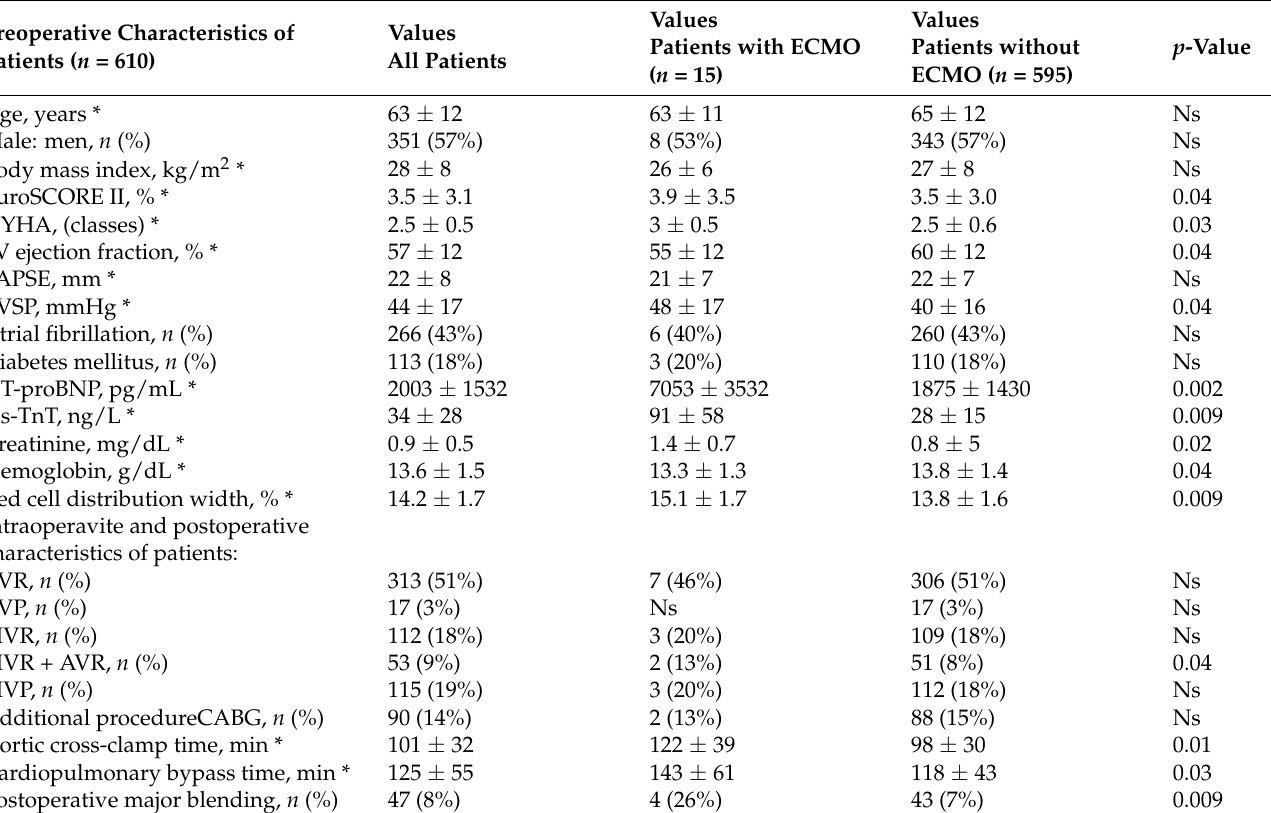
Table 1. Baseline characteristics of the study population.